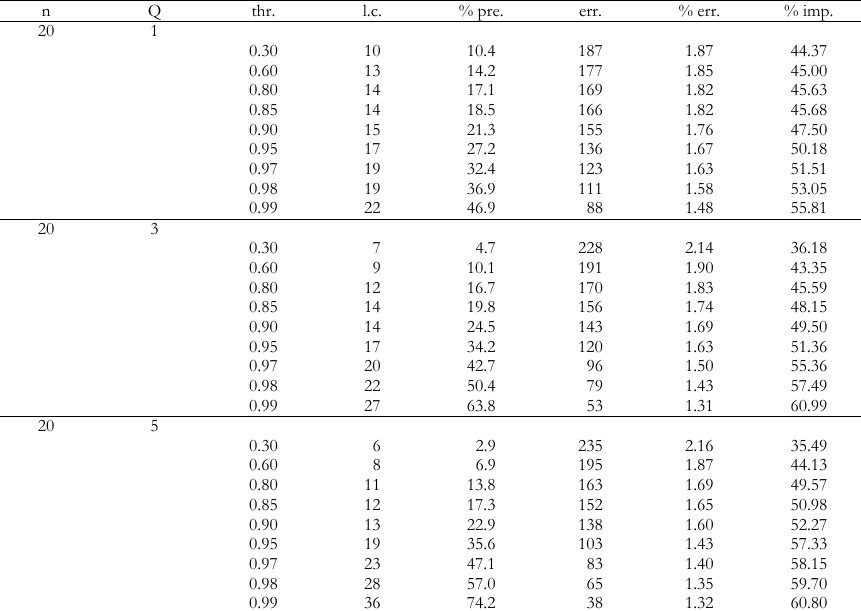
Graph G 1 = (V,E1). Numerical description of the output of the qp-procedure applied for n = 20 and q = 1, 3, 5. The first part of the table gives the quantities used in the construction of the qp-clique plots: some threshold values (thr.) and, for every threshold, the size of the largest clique (l.c.) and the percentage of present edges (% pre.) of the corresponding graph. The last three columns give the number of wrongly removed edges (err.), the percentage of wrongly removed edges with respect to all the removed edges (% err.) and the rate of improvement with respect to the random removal of edges (%